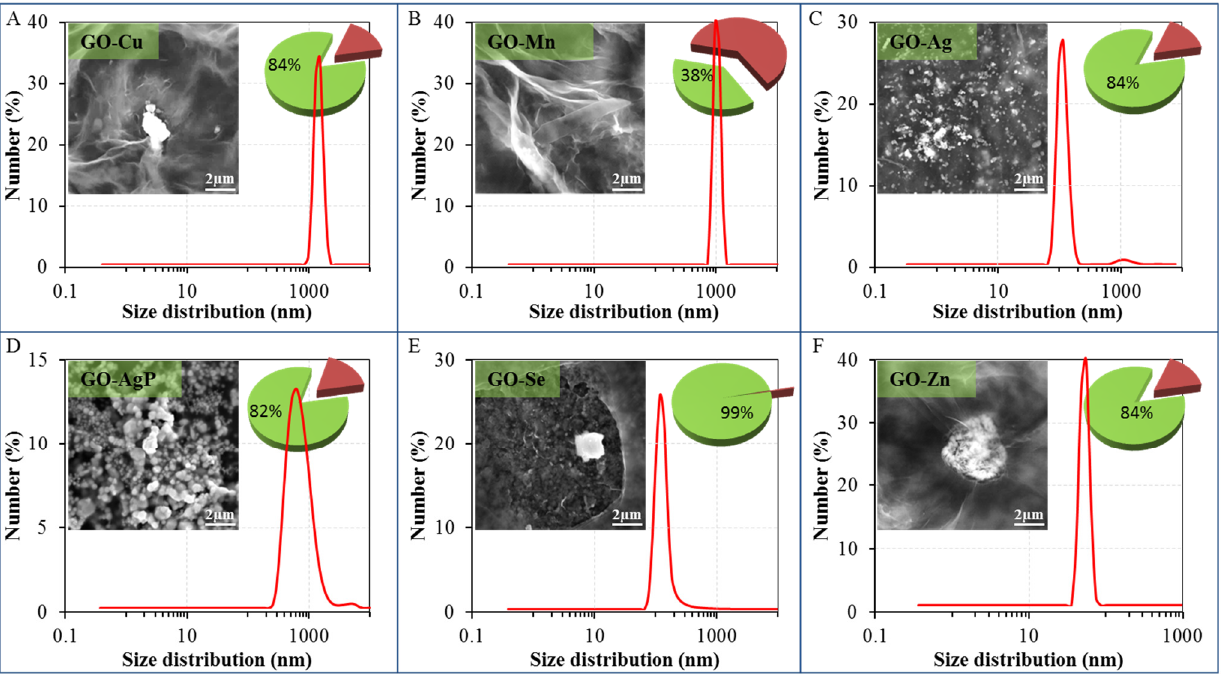
Figure 1. Dynamic light-scattering (DLS) spectra of graphene oxide (GO) composites with metal- or metalloid-based nanoparticles dispersions—size distribution by number: ( A ) GO-Cu; ( B ) GO-Mn; ( C ) GO-Ag; ( D ) GO-AgP; ( E ) GO-Se; and ( F ) GO-Zn. The size of composites was evaluated by Zetasizer Nano NS with a scattering angle θ = 173°. At least 200 particles per sample were measured to obtain the size distribution (the standard spherical particle models were used in DLS). Inserts show their representative SEM images by drying composites dispersions on clean silicon wafers. The length of scale bar is 2 µm. Pie charts show the amount of reduced or precipitated metal or metalloid (green sectors with values) and metal or metalloid ionic form (russet sectors) determined by DPV. The amount of reduced or precipitated metal or metalloid was determined as the difference between total applied amount and amount found by